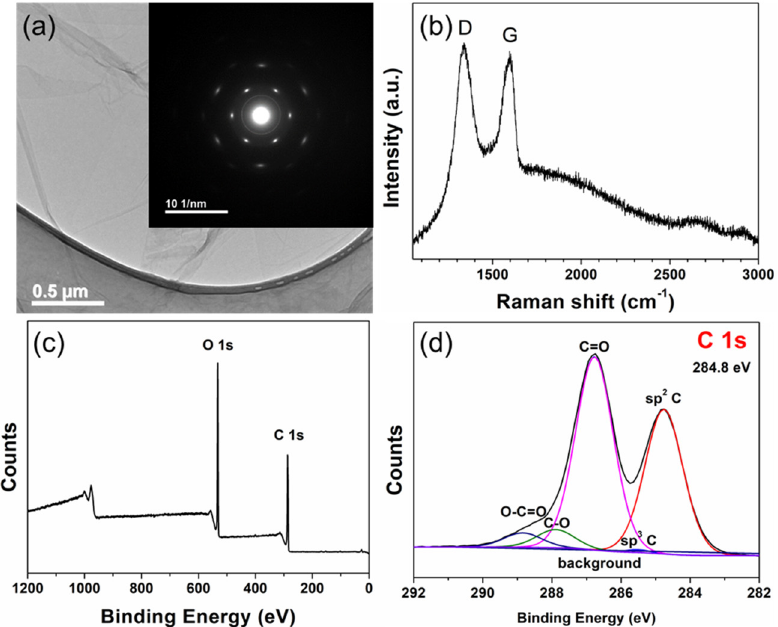
Figure 2. Characterization of the as-produced GO: ( a ) TEM image of GO on lacey carbon film with an inset showing a selected area electron diffraction (SAED) pattern, ( b ) Raman spectrum with the characteristic D and G bands, and ( c ) an XPS survey spectrum and ( d ) an XPS C 1s spectrum.